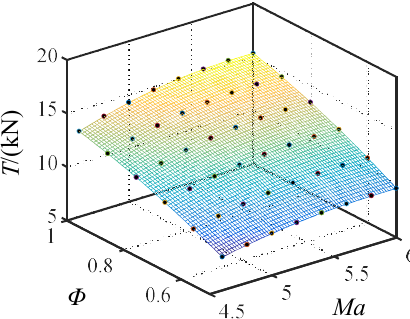
Figure 3. Comparison between the parametric model and original data.